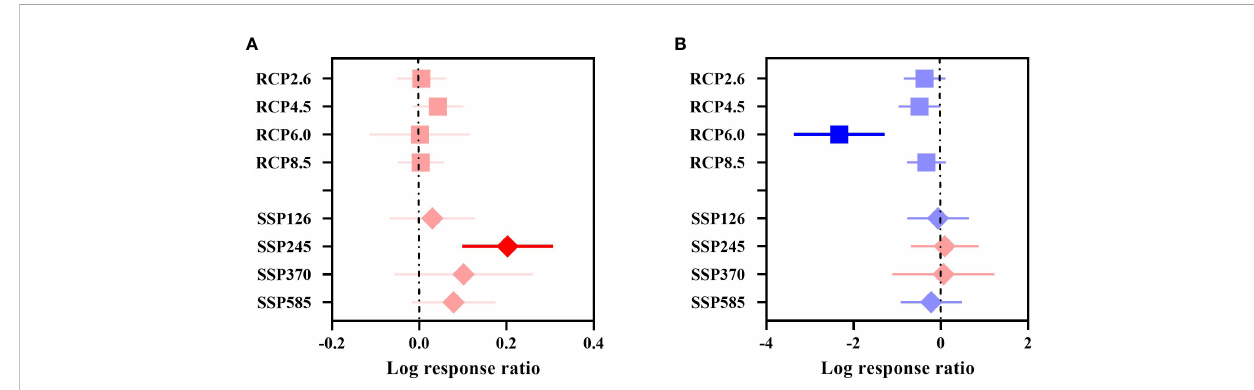
FIGURE 3 Effect sizes of different GHG concentrations. (A) indicates the overall suitable area, and (B) indicates the highly suitable area. The effects of different GHG concentrations on the future overall/highly suitable area (main effects) for woody plants under the RCP and SSP scenarios are indicated. Error lines indicate 95% con fi dence intervals. Positive effect (red color), signi fi cant positive effect (bright red color), negative effect (blue color), and signi fi cant negative effect (bright blue